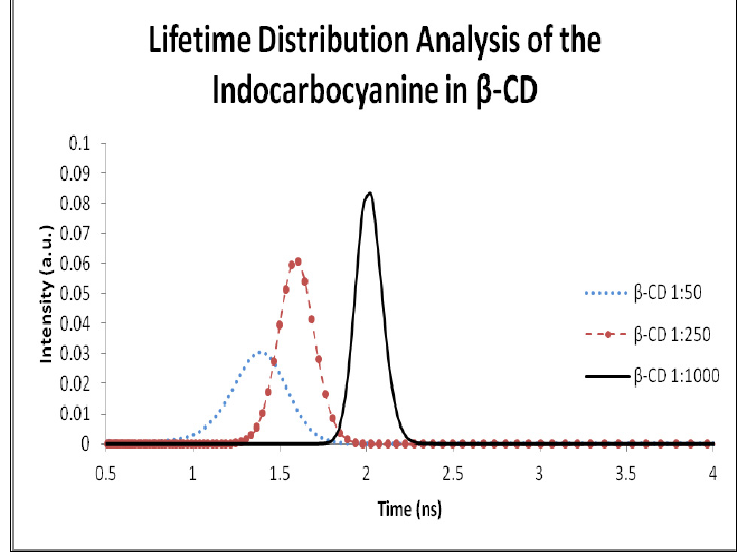
Figure 11. Lifetime distribution analysis of the 3,3'-di(2-sulfoethyl)-indocarbocyanine dye adsorbed onto β -cyclodextrin. Samples concentration was 1:1,000, 1:250 and 1:50 moles of cyanine dye per moles of β -